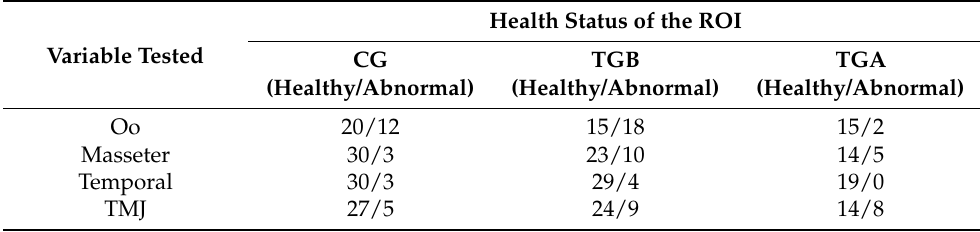
Table 3. Number of healthy and abnormal ROIs assessed in the CG, TGB, and TGA, considering ∆ T = 0.4 ◦ C as the cutoff value.